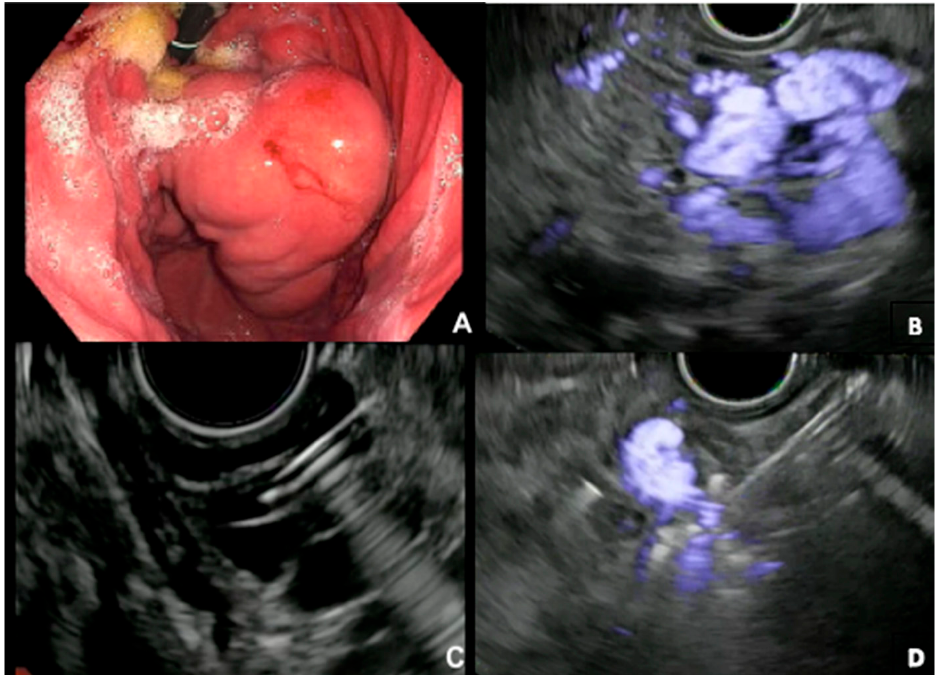
Figure 4. ( A ) Endoscopic examination of large GV on retroflexion. ( B ) EUS confirming Doppler flow within large varices. ( C ) Needle access into GV under endosonographic guidance with coil deployment. ( D ) Diminished Doppler flow on EUS after coil injection.